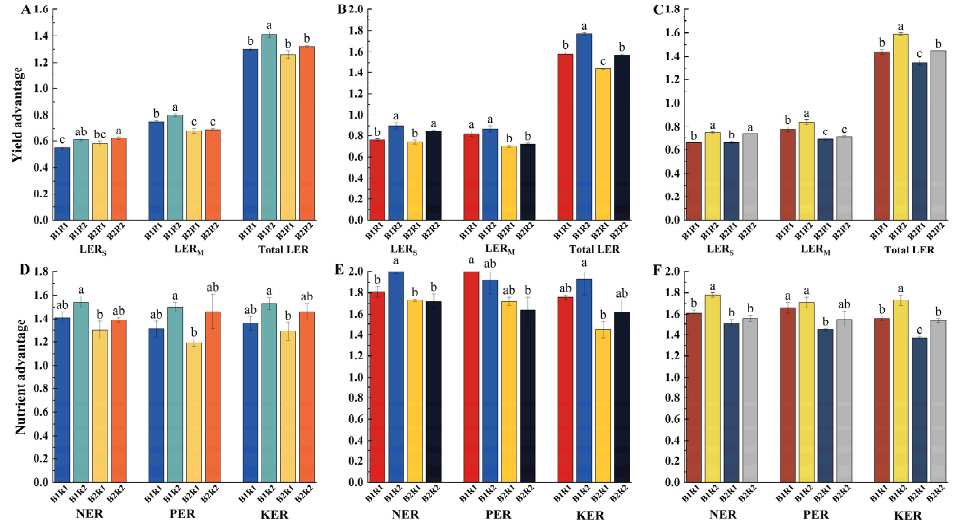
Figure 4. ( A , B ) represent the land equivalent ratios between 2018 and 2019, respectively, and ( C ) represents the average 2 yr land equivalent ratio. ( D , E ) represent the nutrients equivalent ratio be- tween 2018 and 2019, respectively, and ( F ) represents the average 2yr nutrients equivalent ratio. Lowercase letters above the bars indicate significant differences ( p < 0.05). Values are means ± stand- ard error.